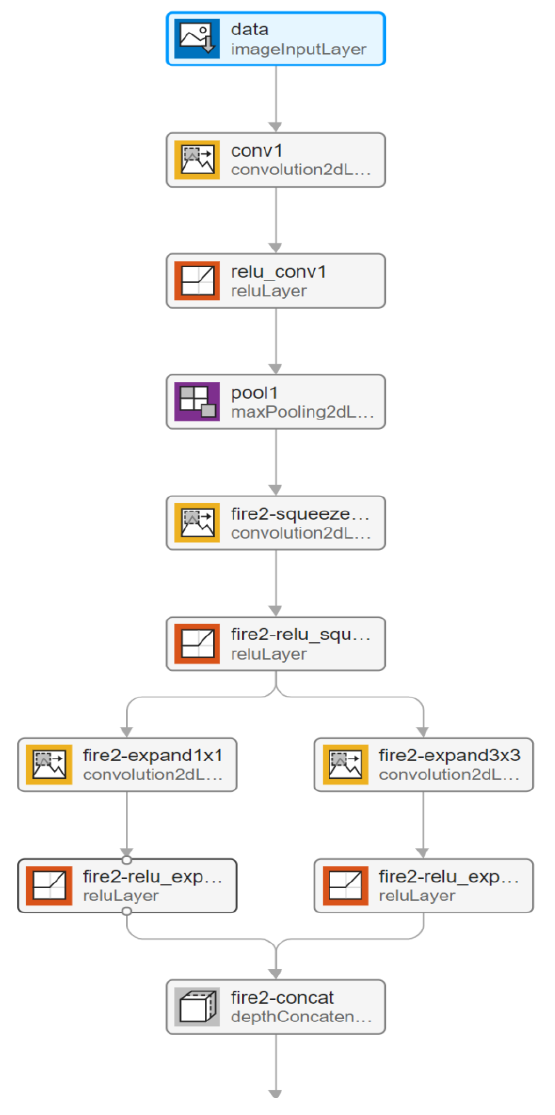
Fig. 7. SqueezeNet Fire Module